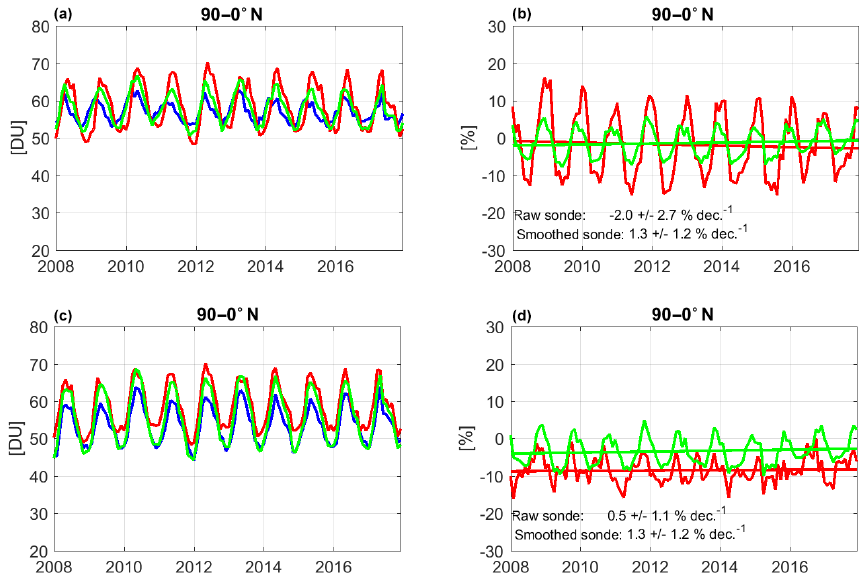
Figure 16. Time series of SOFRID-O3 (a) v1.6 and (c) v3.5 surface–300hPa columns for the Northern Hemisphere (0–90 ◦ N). Blue lines indicate IASI retrievals, red lines indicate raw sonde data, and green lines indicate smoothed sonde data. Differences between IASI and sonde data for (b) v1.6 and (d) v3.5. Red lines indicate raw sonde data and green lines indicate smoothed sonde